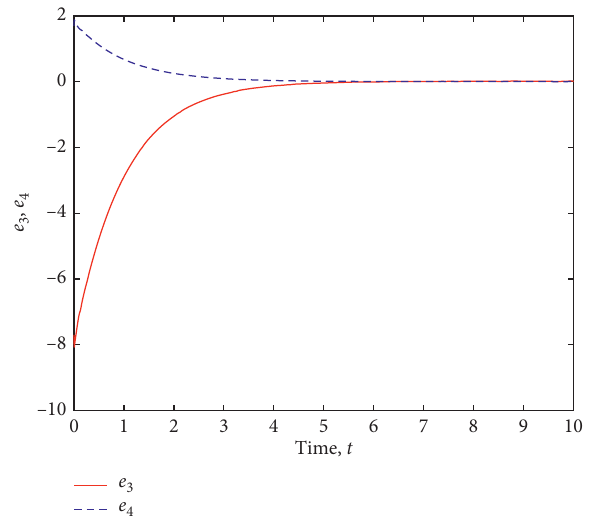
Figure 9: The phase portrait of master subsystem and the slave subsystem.